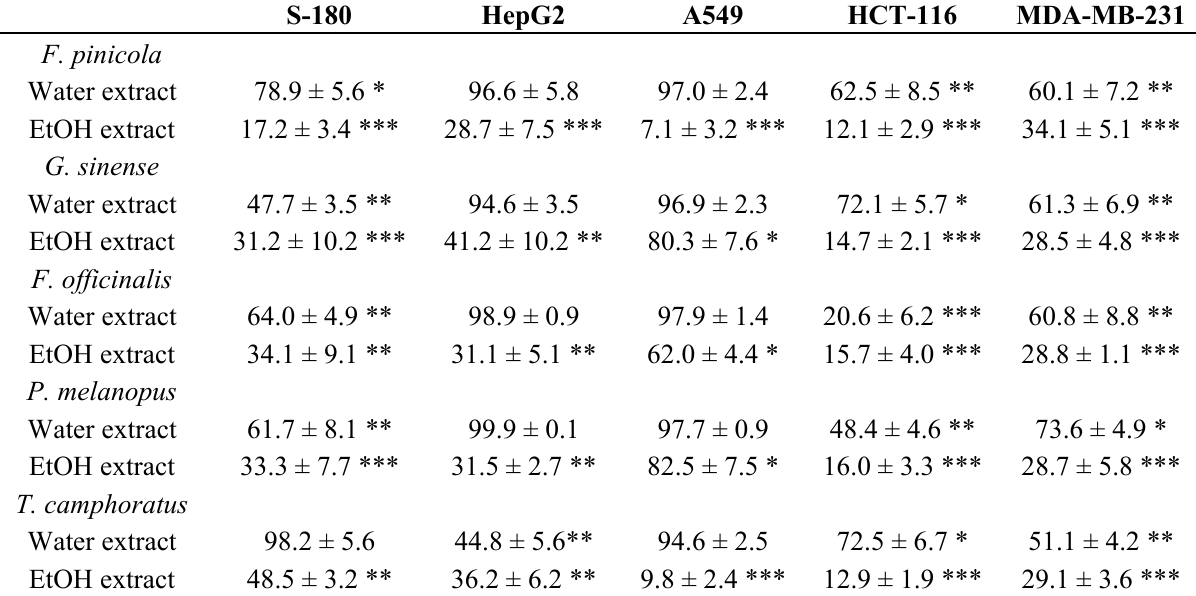
Table 1. Growth-inhibition effect of different reishi mushroom extracts on different cancer (A549), colon cancer (HCT-116) and breast cancer (MDA-MB-231) cells were treated